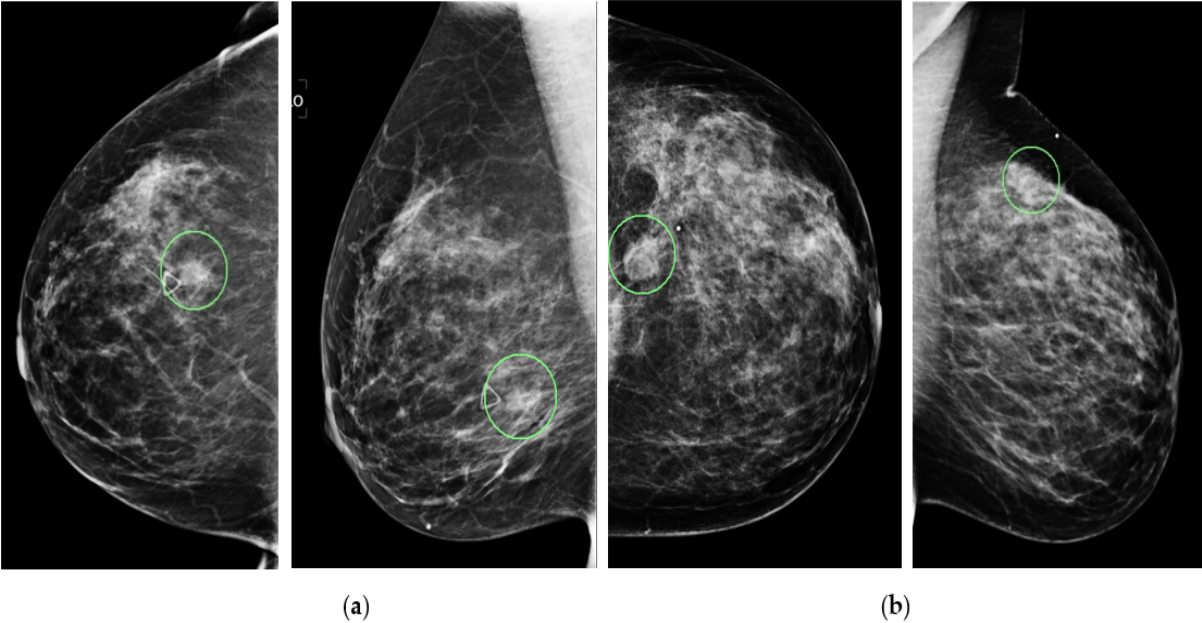
Figure 1. Illustration of four mammograms of CC and MLO views of two patients in which two suspicious mass type lesions are detected, as circled by green rings. Two images of one patient depict a benign lesion ( a ) and two images of another patient depict a malignant lesion ( b ).